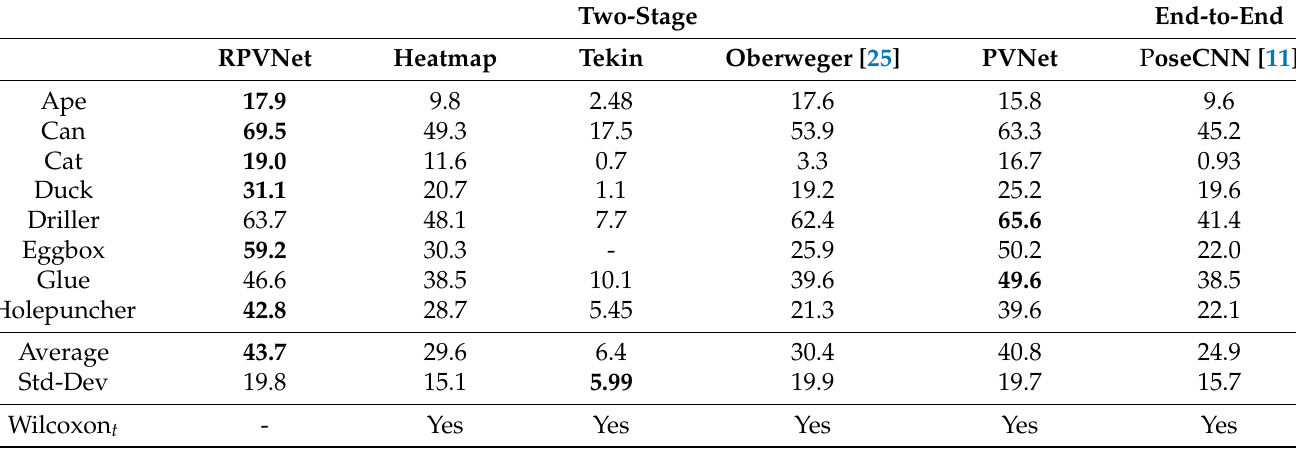
Table 2. Test results of accuracy on Occlusion